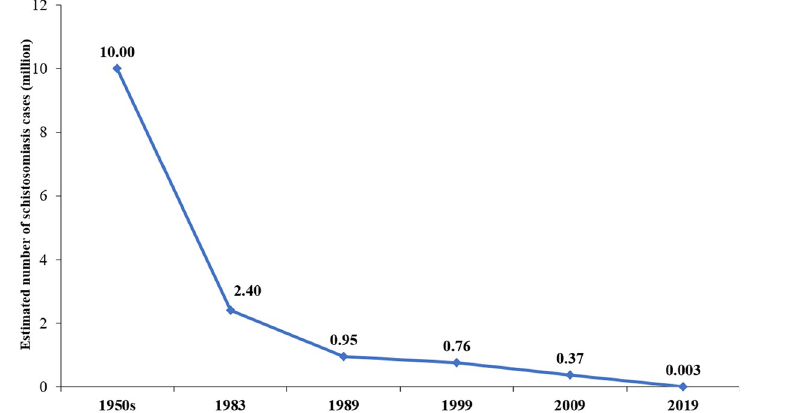
Fig 1. Changes in the estimated number of schistosomiasis cases in China from 1950s to 2019.